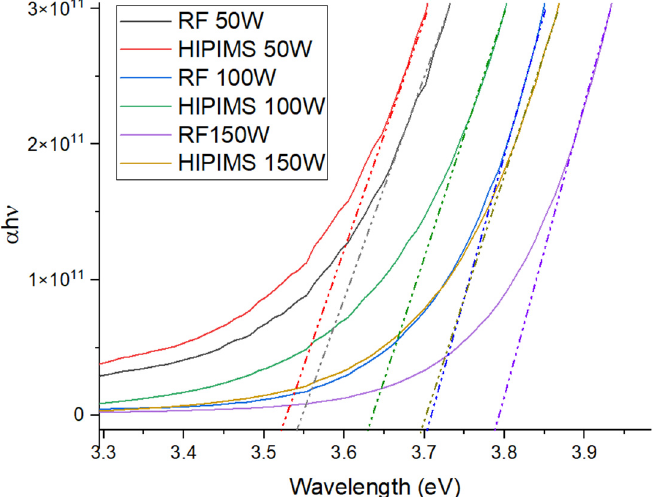
Figure 5. Tauc plot used to determine the band gap of each of the samples.